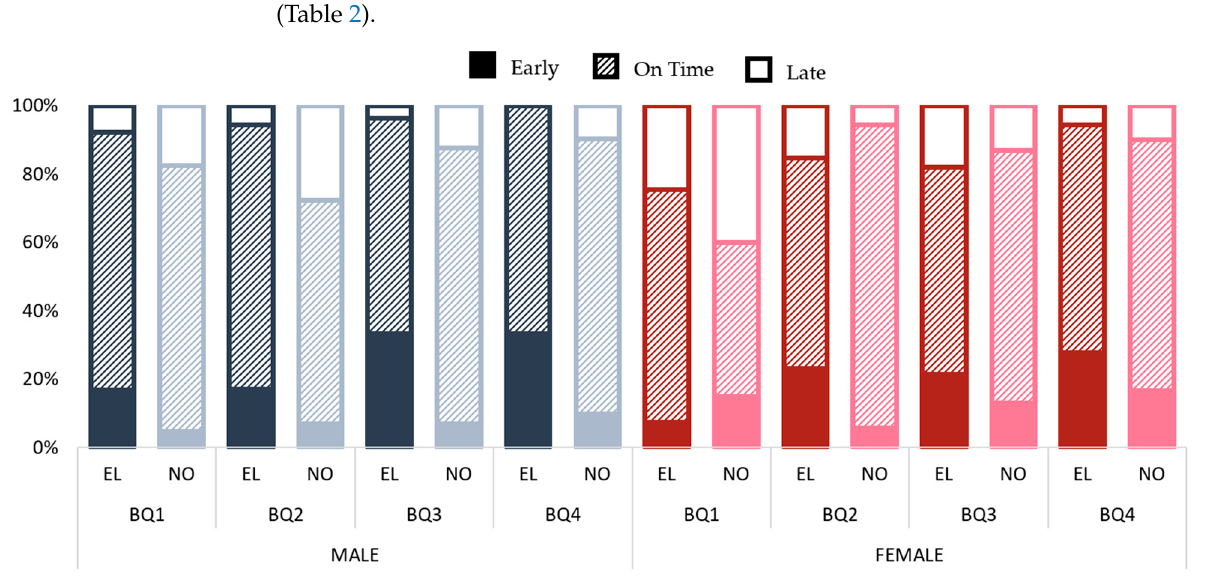
Figure 2. Maturity status distribution by birth quarter in elite and nonelite in male and female academies. EL = elite; NO = nonelite. Table 2. Relative age effect in the different elite and nonelite academies, differentiating between genders.